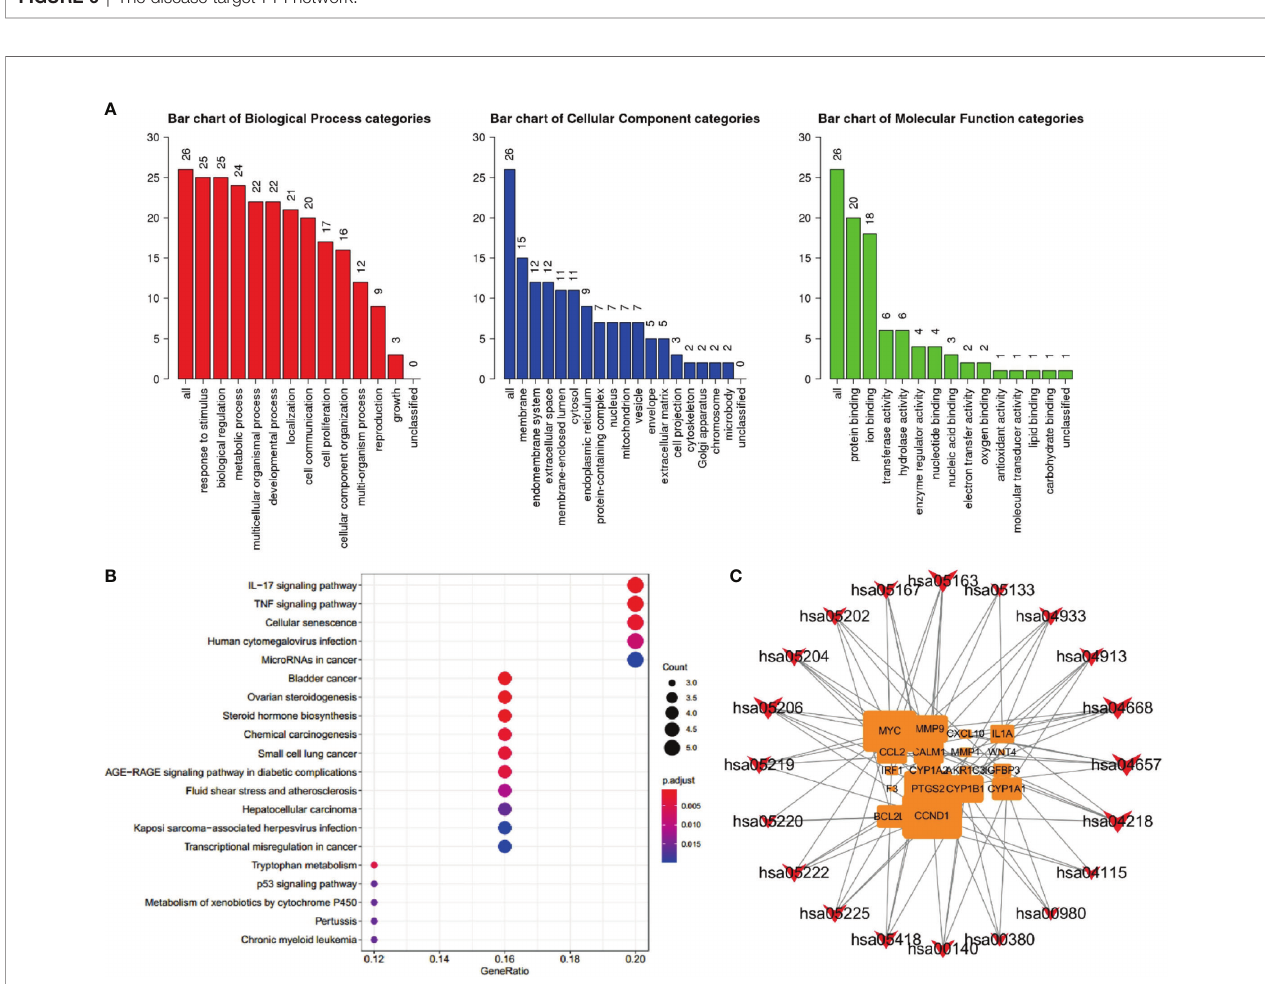
FIGURE 7 | Component target network analysis of QYSLS in the treatment of EGFRI-related adverse skin reactions. (A) GO analysis of biological process, cellular component, and molecular function terms was performed on major targets of QYSLS. (B) KEGG analysis for the major targets of QYSLS. (C) Target-pathway network diagram of KEGG